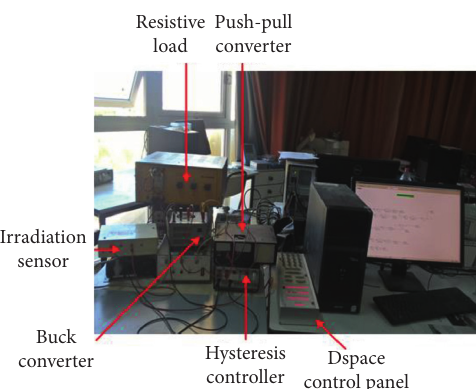
Figure 26: Configuration of the experimental set